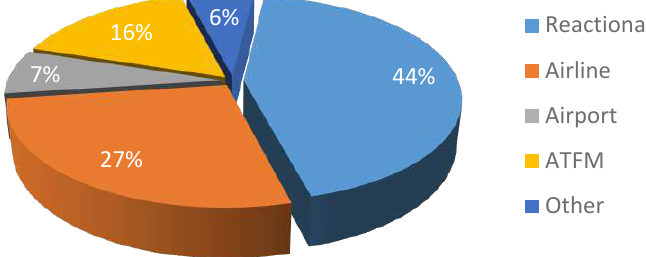
Figure 4. The main reasons for flights